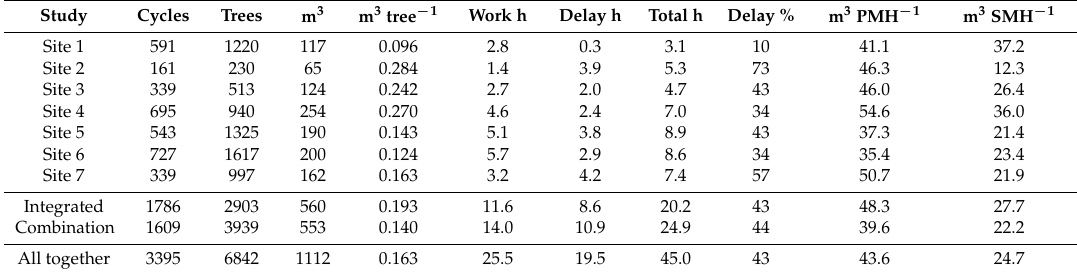
Table 3. Description of the study: totals and productivity figures derived from